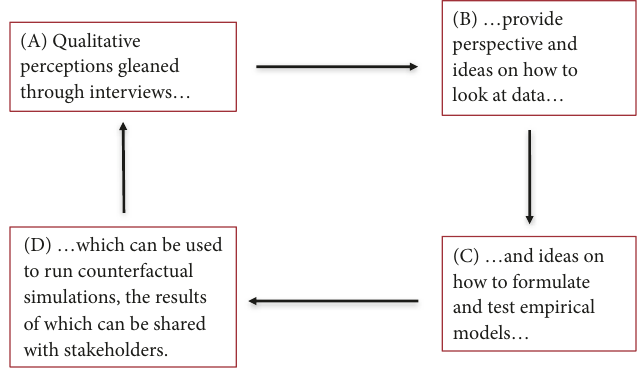
Figure 2: A model of integrating qualitative and quantitative data on electricity policy formation.